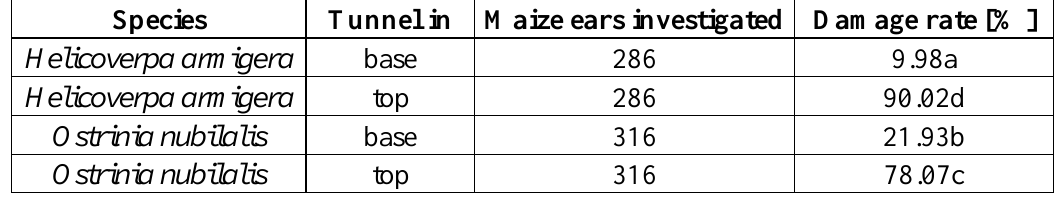
Table 4. Position of Ostrinia nubilalis and Helicoverpa armigera tunnels in infected maize cobs